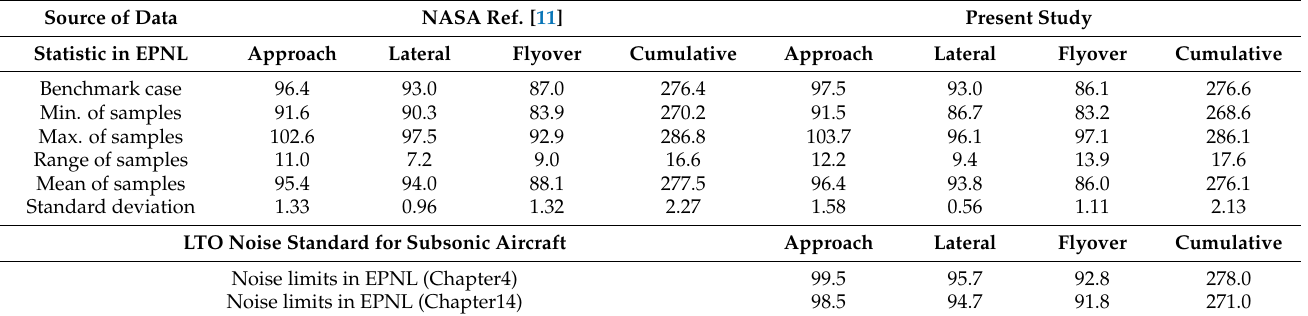
Table 4. Summary of the results and statistics of the system noise assessment of NASA 55t STCA. Source of Data NASA Ref. [11] Present